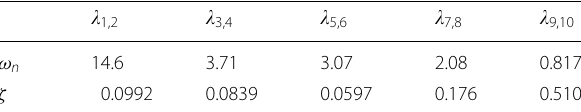
Table 4 Damping ratios and natural frequencies of the Baxter robot performing Cartesian impedance control for a given set of damping and stiffness matrices